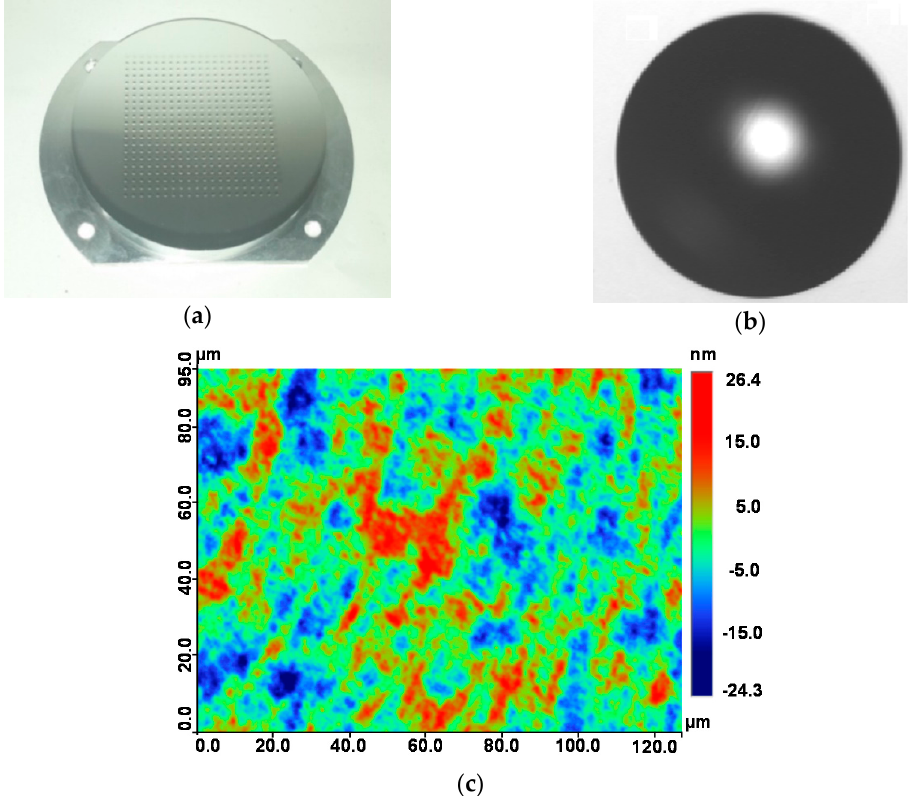
Figure 2. Finished 6061-T6 aluminum alloy mold: ( a ) photograph of the processed sample of the dense microlens array (MLA) mold (20 × 20 array), ( b ) edge profile of the processed sample, and ( c ) surface roughness of the aluminum alloy MLA mold (Sa = 4.932 nm).